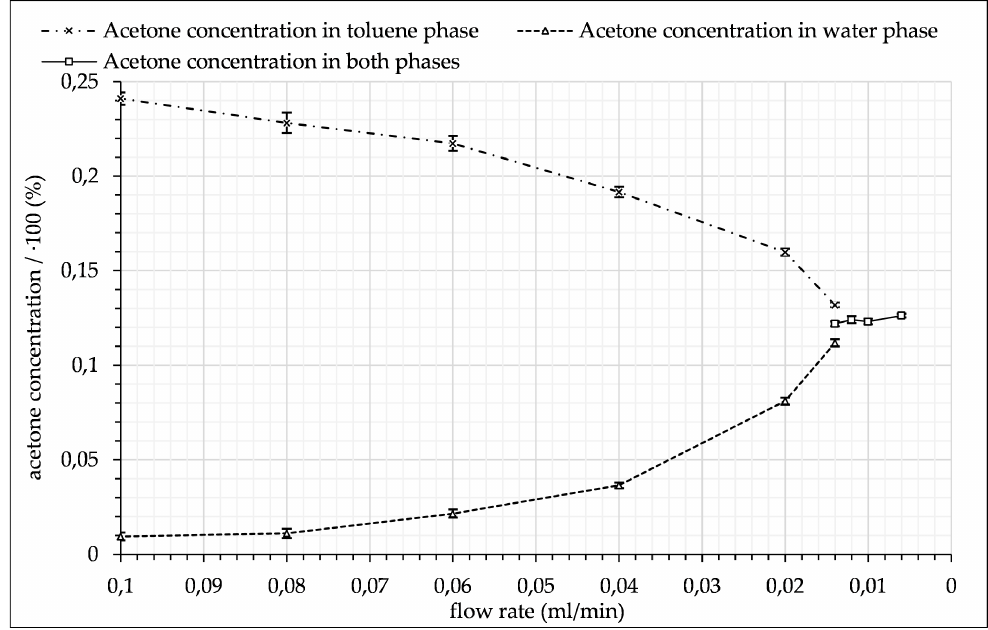
Figure 14. Acetone concentration in toluene droplets and water droplets as a function of the flow rate.